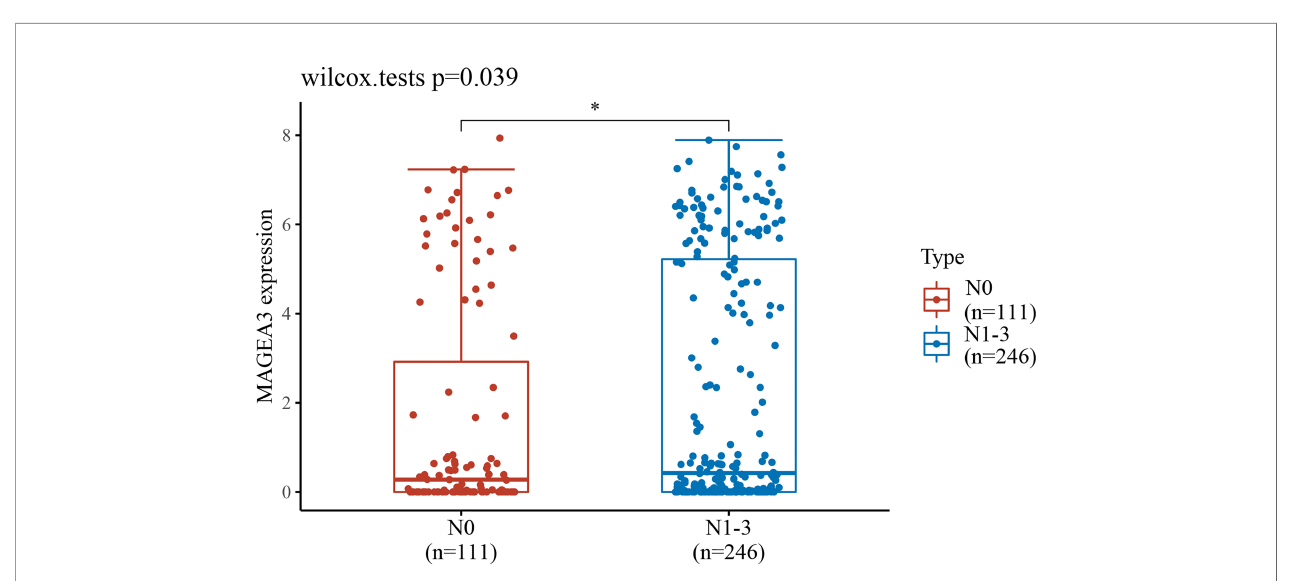
FIGURE 2 | MAGEA3 expression increased signi fi cantly in gastric cancer – caused lymph node metastasis. * p < 0.05.